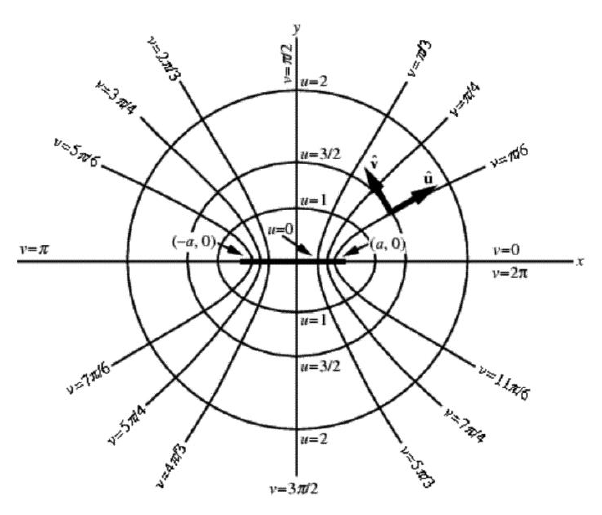
Figure 8: Geometry of the elliptic cylindrical coordinates.